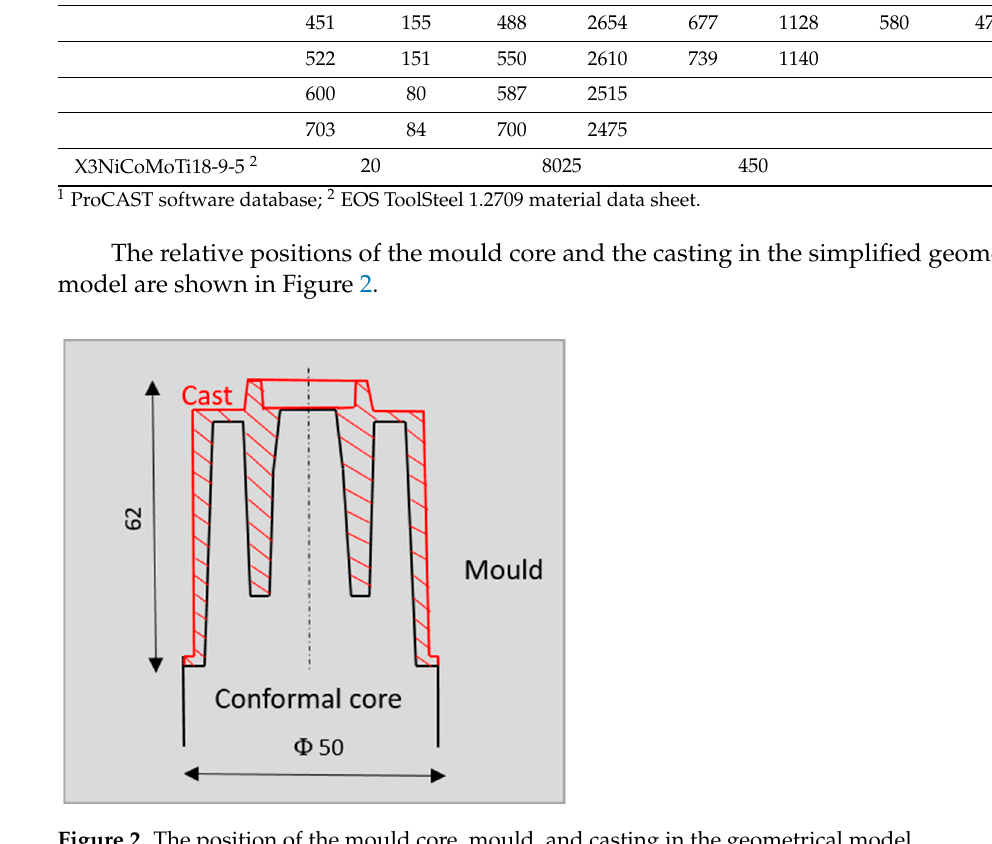
Table 4. Thermophysical properties describing the constitutive model of the cast alloy AlSi9Cu3 and SLM 1.2709 maraging steel mould.